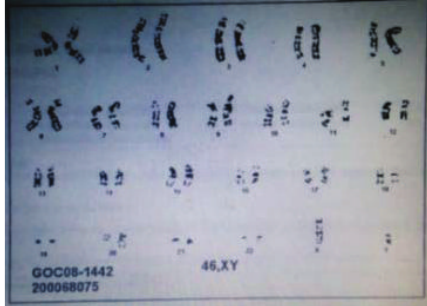
Figure 2: Normal cytogenetic study (bone marrow biopsy sample).